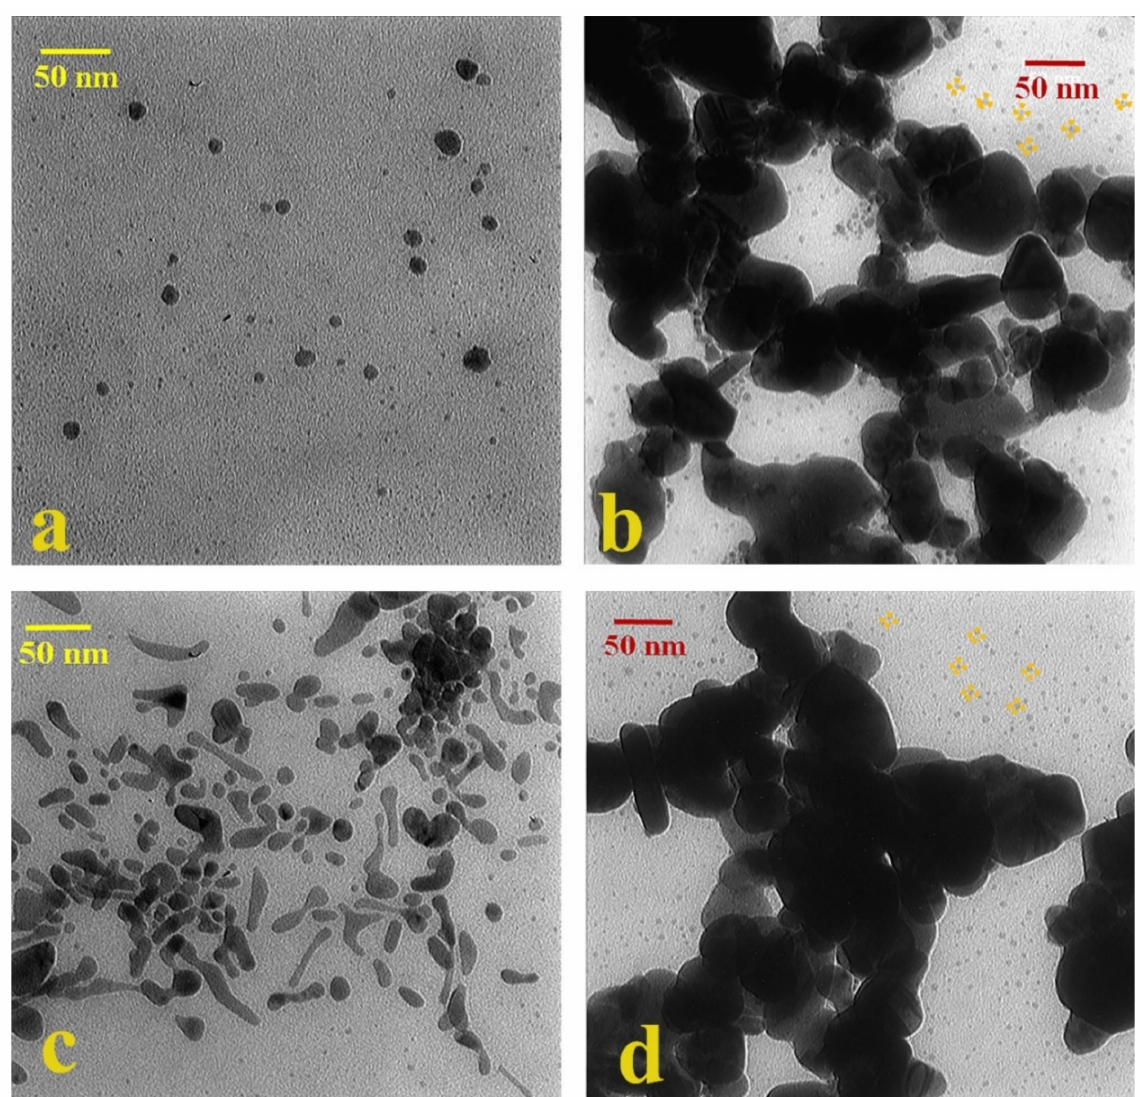
Figure 4. TEM images of ( a ) Au@Ag (B); ( b ) Au@Ag (B)-MOR; ( c ) Au@Ag (P); and ( d ) Au@Ag (P)-MOR.